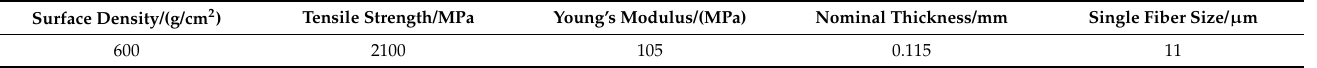
Table 1. Material properties of basalt fiber unidirectional fabric.